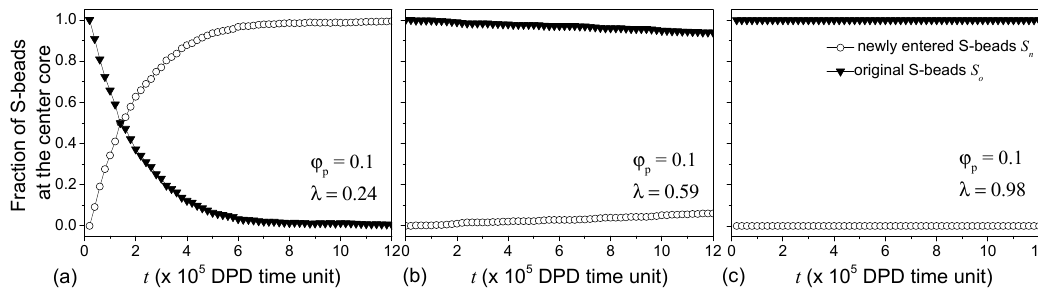
Figure 7. The fraction of original and new S-beads in the cores of vesicles formed at ϕ p = 0.1 and λ = ( a ) 0.24; ( b ) 0.59 and ( c ) 0.98. Triangles and circles correspond to the S-beads that were and were not at the cores at a reference point in time ( t = 0) respectively.